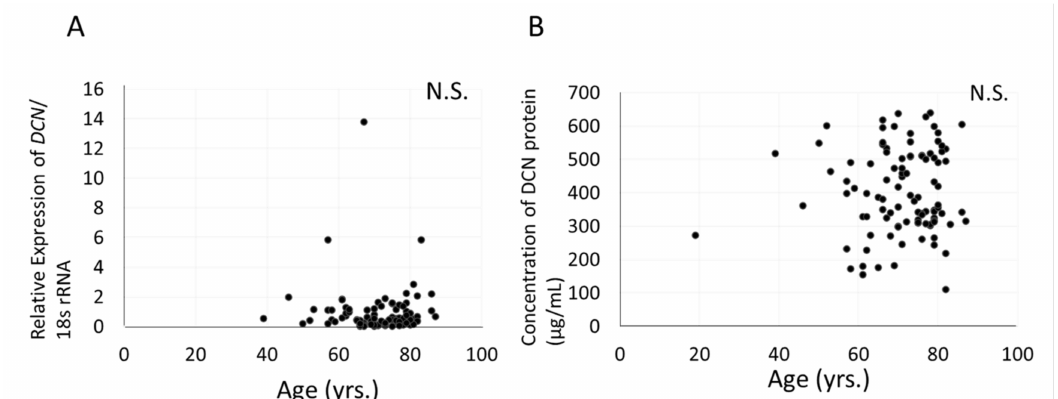
Figure 8. Relationship between age and Dcn mRNA expression in human LECs, and between age and concentration of DCN protein in human aqueous humor. RT-qPCR validation of Dcn mRNA expression in human LECs ( A ) and ELISA for DCN concentration in aqueous humor from patients with cataract ( B ) compared to that in the control (human LECs obtained from the clear lens after vitrectomy for removal of epiretinal membrane). N.S.: not significant; yrs: